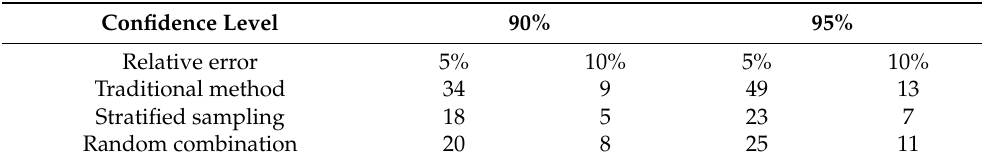
Table 1. Reasonable sampling numbers obtained for different methods at certain confidence levels and error